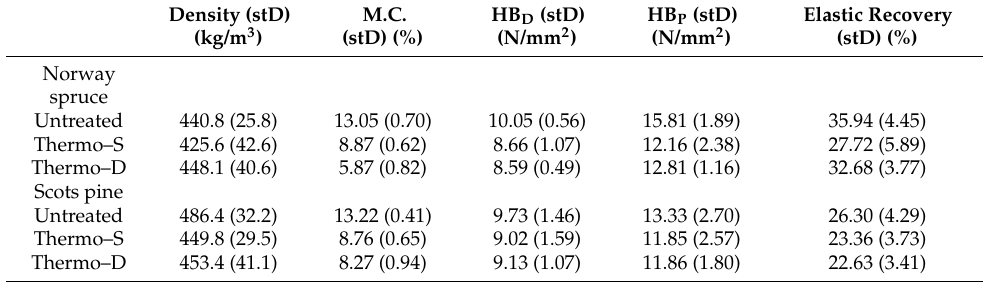
Table 4. Brinell hardness results for unmodified and ThermoWood ® treated Norway spruce and Scots pine. stD—standard deviation.